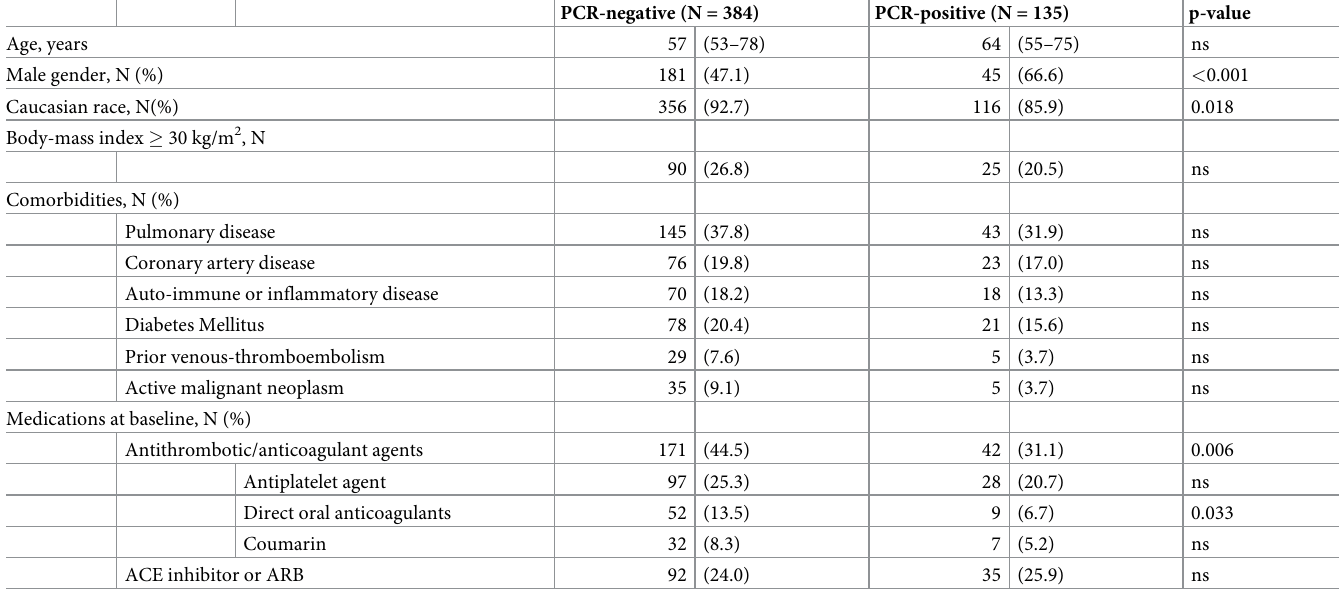
Table 1. Baseline characteristics of PCR SARS-CoV-2 negative and positive